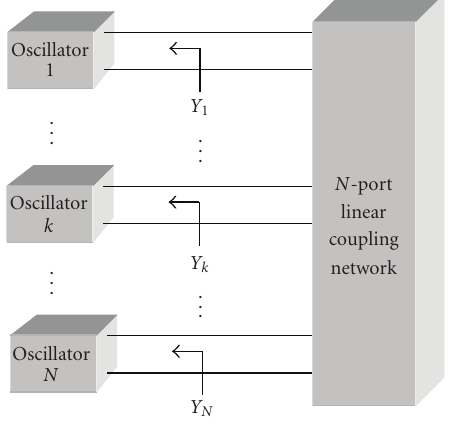
Figure 2: The coupled oscillator